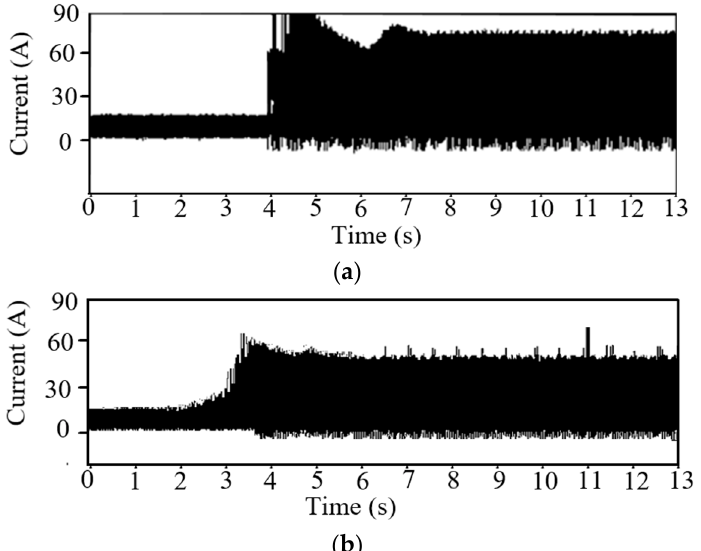
Figure 15. Comparison of current waveforms for sudden increase in torque. ( a ) Current waveform of APC speed control based on switching angle. ( b ) Current waveform based on current chopping speed control.